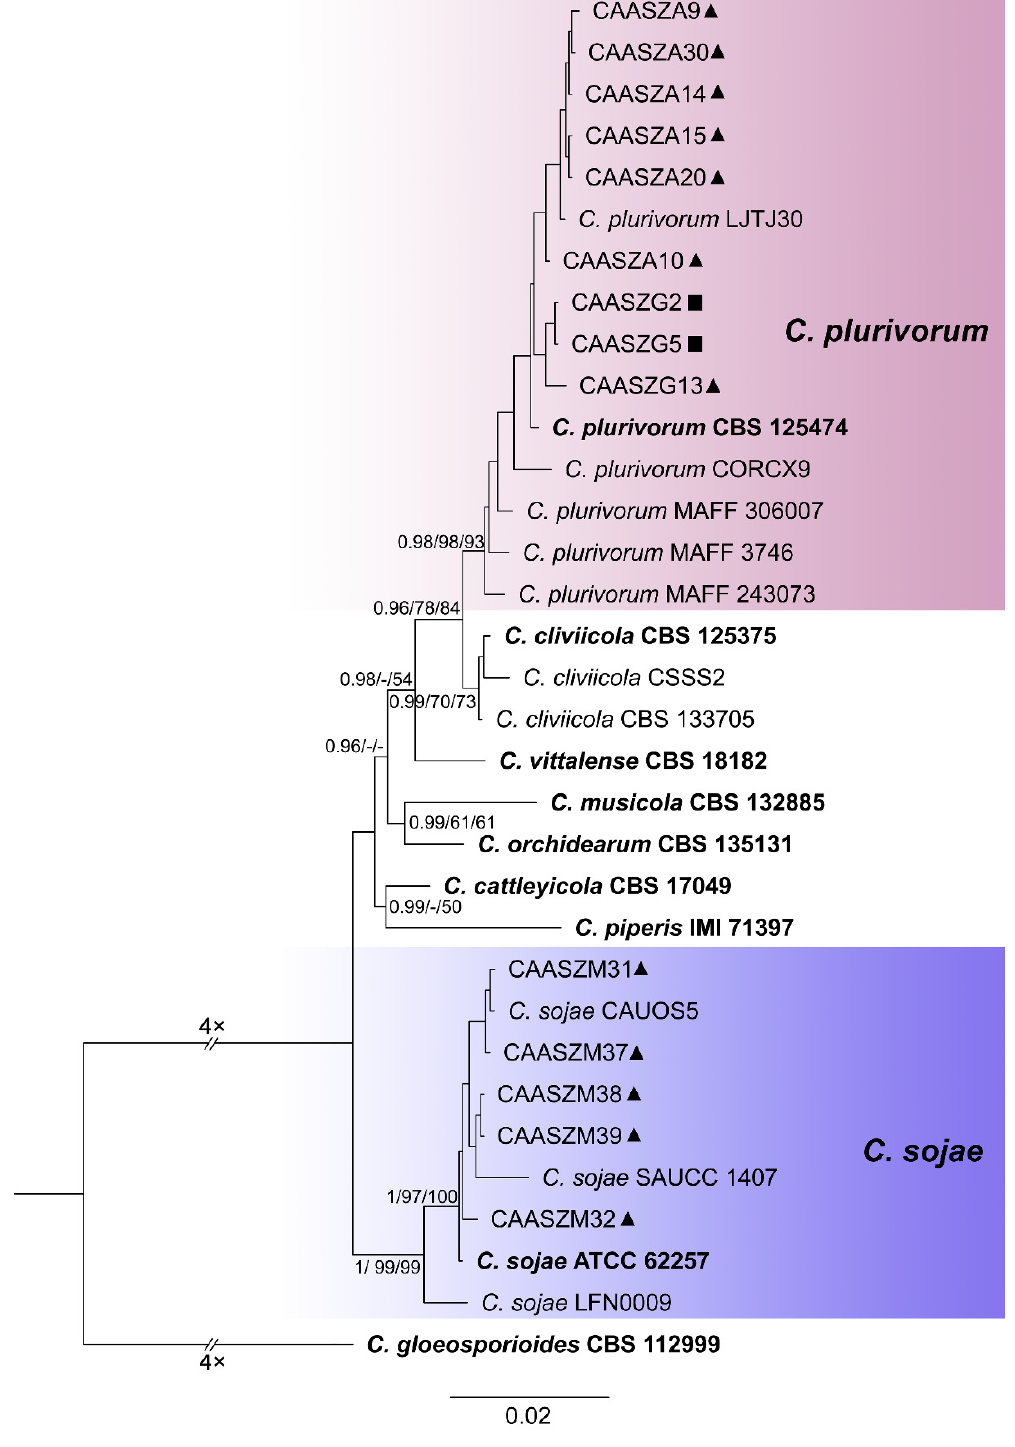
Figure 5. A Bayesian inference phylogenetic tree of 32 isolates in the C. orchidearum species complex. The species C. gloeosporioides (CBS 112999) was selected as an outgroup. The tree was built using concatenated sequences of the ITS, gadph , chs-1 , his3 , act , and tub2 genes. Bayesian posterior probability (PP ≥ 0.90), MP bootstrap support values (MP ≥ 60%), and iqtree bootstrap support values (ML ≥ 50%) were shown at the nodes (PP/MP/ML). Ex-type isolates are in bold. Colored blocks indicate clades containing isolates from Citrullus lanatus in this study; triangles indicate strains isolated from leaves, rectangle indicate strains isolated from stems. The scale bar indicates 0.02 expected changes per site.